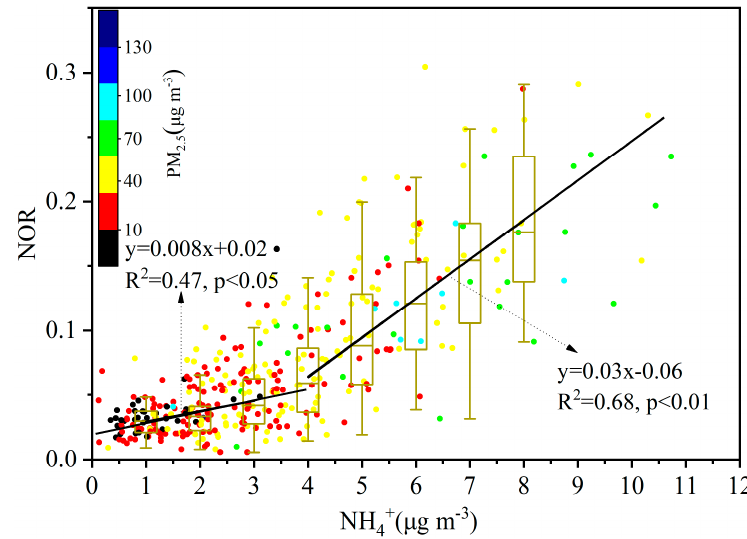
Figure 6. Relationship between NH 4 + and NOR and color-coded by PM2.5 concentrations. The NOR data were also binned according to NH 4 + concentrations ( < 1 µ g m − 3 , 1–2 µ g m − 3 , 2–3 µ g m − 3 , 3–4 µ g m − 3 , 4–5 µ g m − 3 , 5–6 µ g m − 3 , 6–7 µ g m − 3 , > 7 µ g m − 3 ), respectively. For each box plot of NOR, the solid line inside the box represents the median, the box encompasses the 25th to 75th percentiles and the bar denotes the 5th and 95th percentiles.